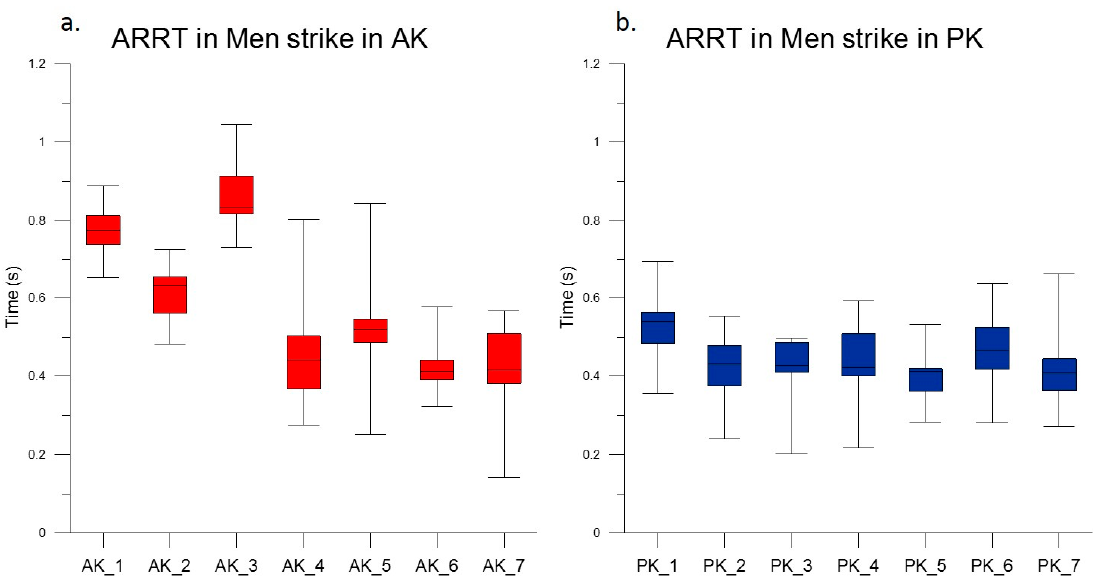
Figure 2. Comparison of the ARRT in Men strikes between amateur (AK) and professional (PK).